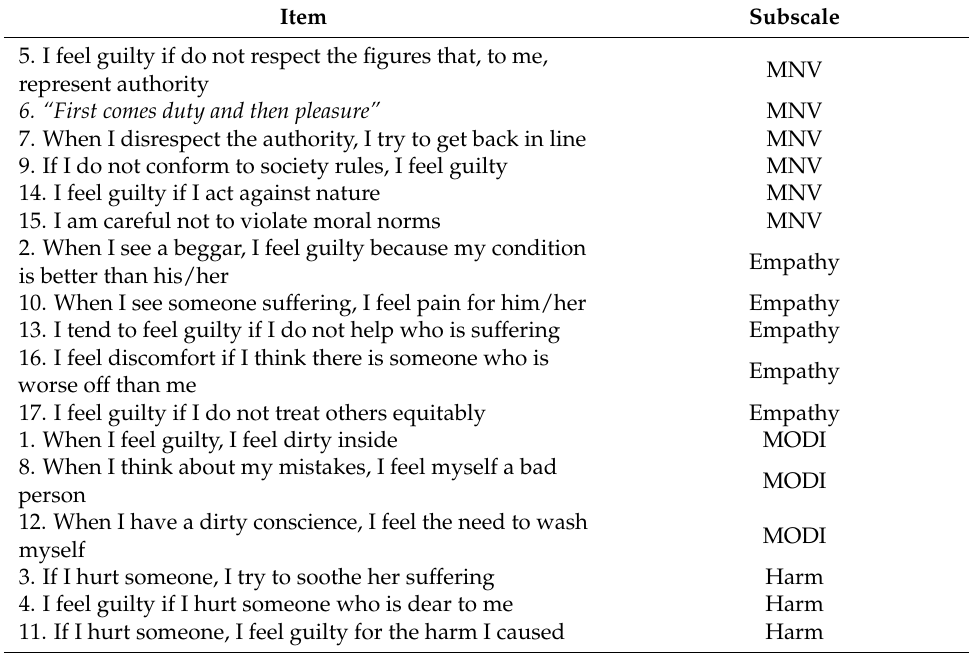
Table A1. MOGS Items (translated from Italian) and their respective